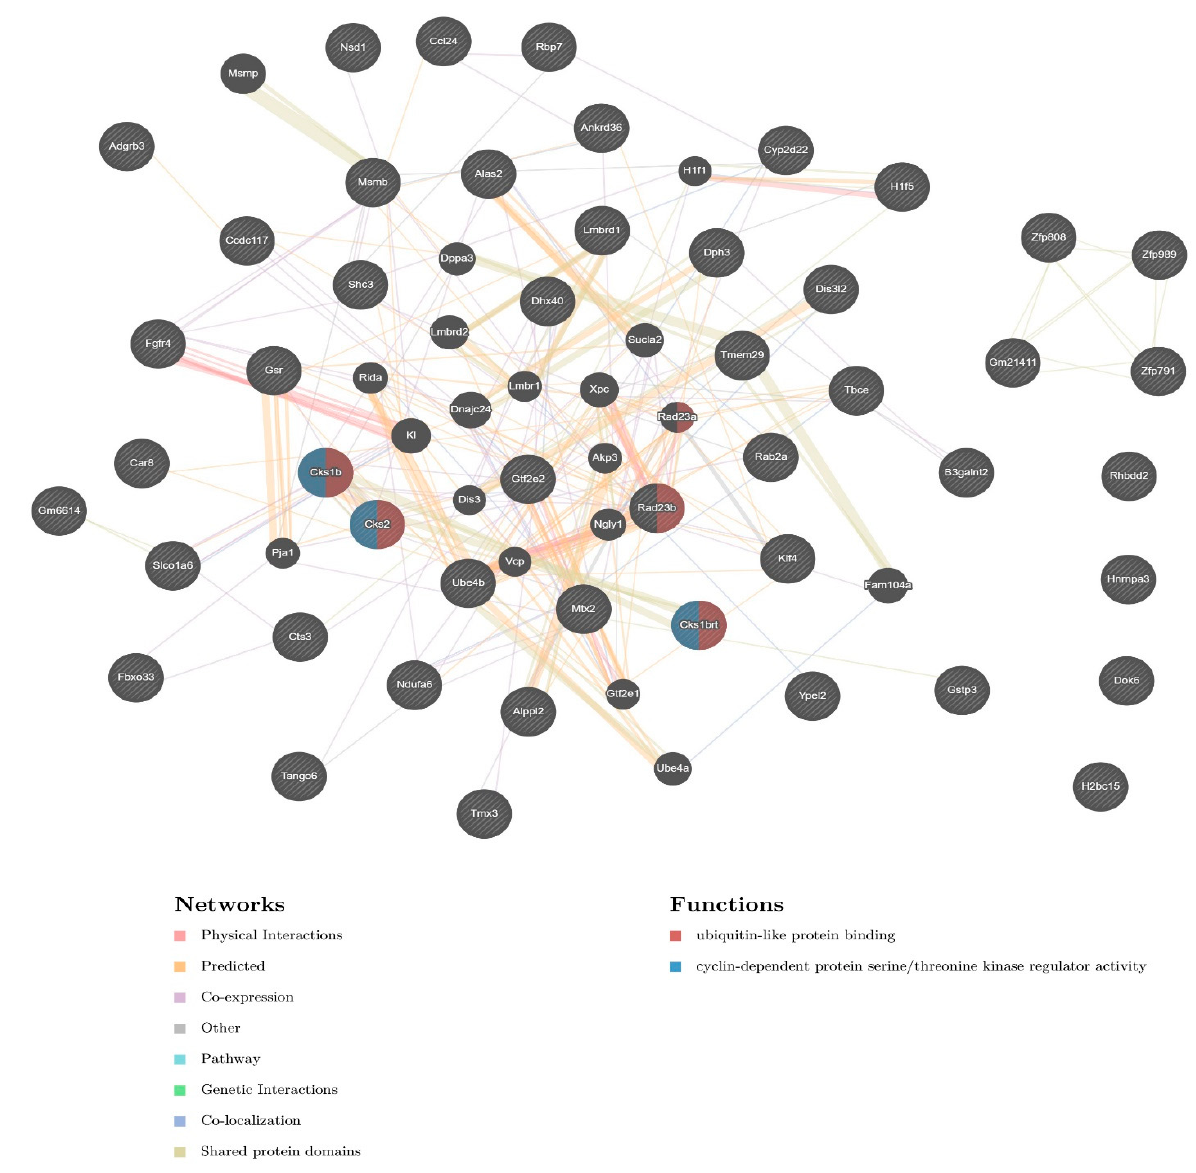
Figure 4. Network analysis of CRE-VL30-related genes. The final network includes 47 input genes (indicated with stripes) and 20 related genes. In total, 67 genes and 353 total links are presented. Interactions in the network are depicted in different line colours while functions are depicted in coloured circles representing individual proteins (see legend above for details).